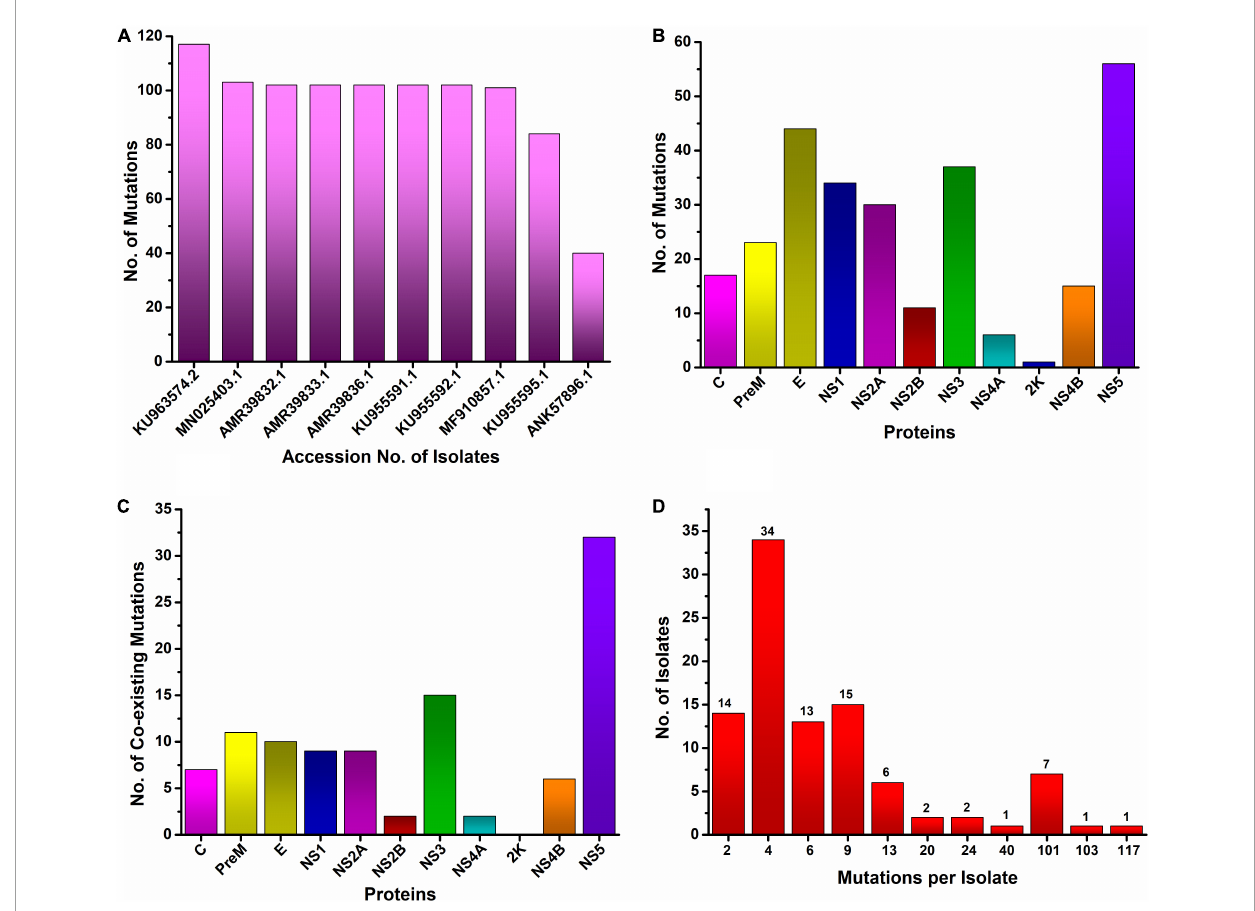
FIGURE2 Worldwide mutational analysis of the ZIKV genome per isolate (A) . Top 10 most mutated ZIKV isolates along with accession no. (B) . Frequency distribution of substitution in each protein of ZIKV (C) . Number of coexisting mutations in each protein of the ZIKV. (D) Frequency distribution of ZIKV isolates harboring varying numbers of coexisting